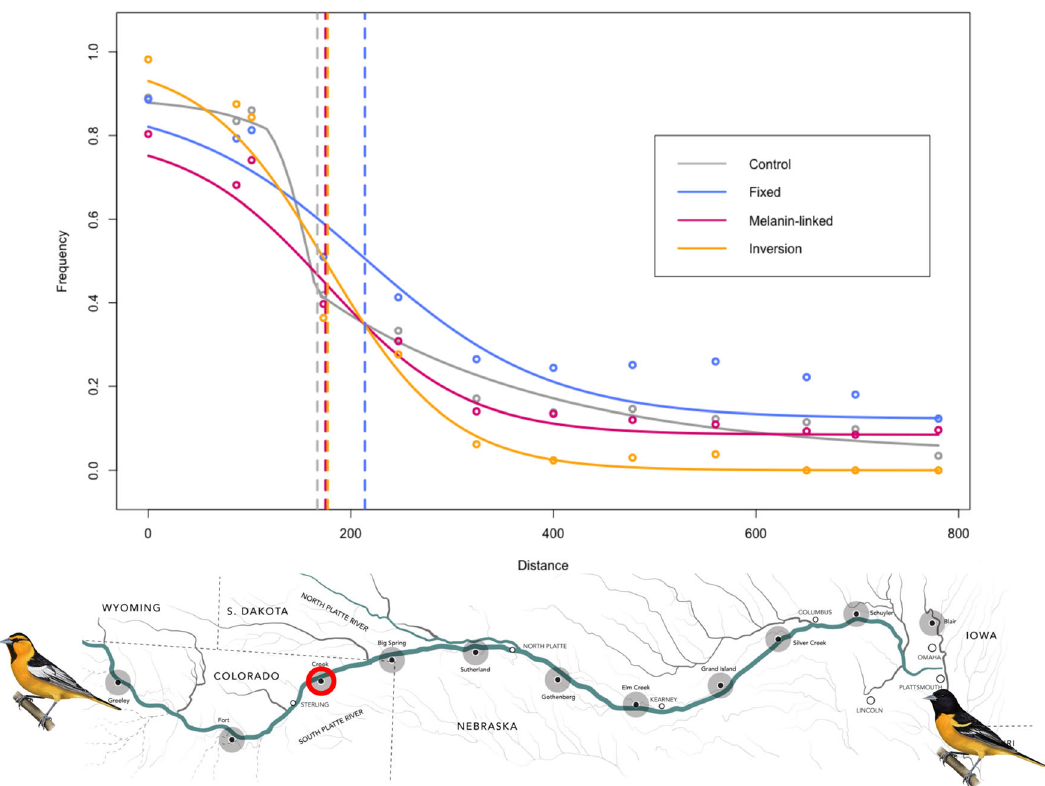
Fig. 4 Genome-wide patterns of introgression between Bullock ’ s and Baltimore orioles. Geographic clines for 4 marker types (top): control (ddRAD sequencing data set from Walsh et al., 2019), fi xed amplicons, amplicons putatively linked to melanogenesis, and inversion-linked amplicons. Individuals were sampled along the Platte River transect (bottom) and the clines run from west to east. Crook, Colorado is circled in red and is the approximate center of the control, melanin-linked, and inversion-linked clines. Map inset illustrated by Megan Bishop,